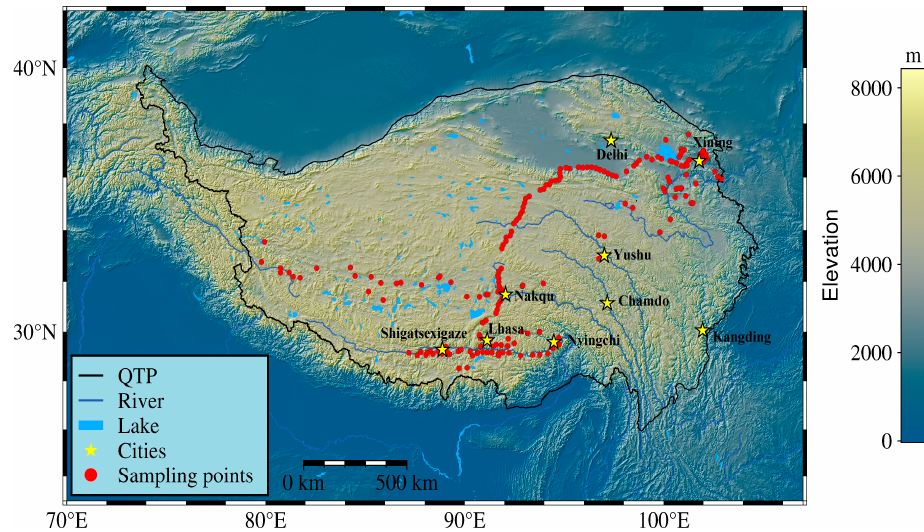
Figure 1. Distribution of sampling points in the QTP.